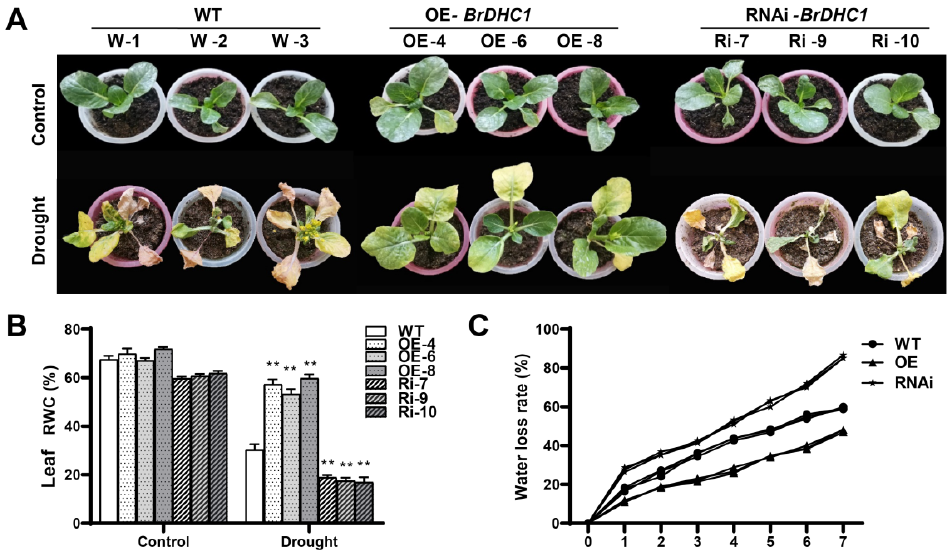
Figure 5. Phenotyping of the wild-type and transgenic plants under normal conditions and under natural drought stress. ( A ) Phenotypic analysis of WT, OE- BrDHC1 , and RNAi- BrDHC1 transgenic plants under 10 d natural drought ( n = 6). ( B ) Analysis of leaf relative water content under natural drought of WT, OE- BrDHC1 , and RNAi- BrDHC1 transgenic plants for 10 d (data represent the means ± SD of 6 replicates; Student’s t test was performed to compare differences between the wild- type and the transgenic plants under natural drought stress, along with one-way analysis of vari- ance (ANOVA), ** p value < 0.01). ( C ) Leaf water loss rate analysis of WT, OE- BrDHC1 , and RNAi- BrDHC1 transgenic plants after 10 d of natural drought (data represent the means ± SD of 3 repli- cates).